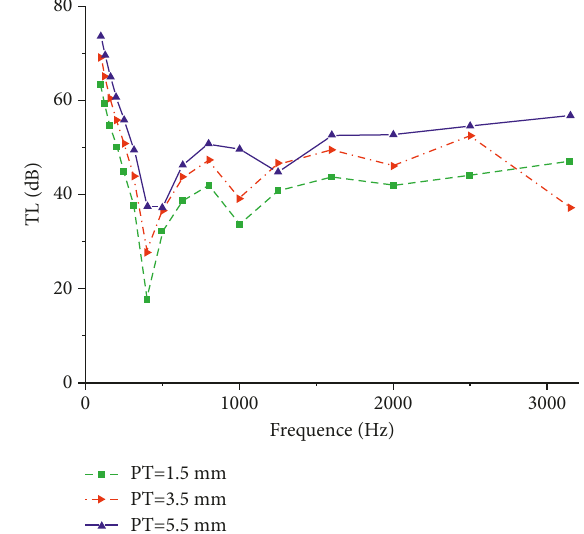
Figure 11: Influence of panel thickness on sound insulation curve of